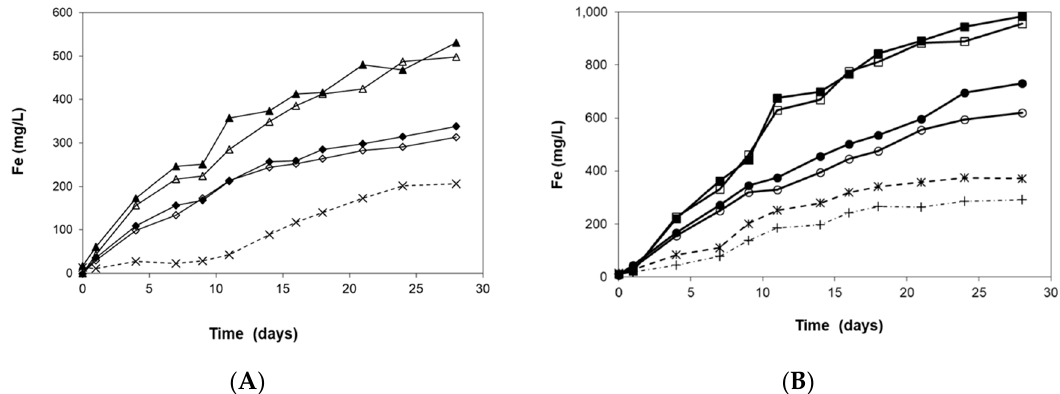
Figure 1. Total soluble iron (solid symbols) and ferrous iron (hollow symbols) leached from the laterite ore ( A ) under anoxic conditions using A. ferrooxidans at pH 1.8 and 30 °C, sparged with (i) oxygen-free nitrogen (OFN) ( ♦ , ◊ ) and (ii) OFN enriched with 10% of CO 2 ( ▲ , Δ ). ( B ) Under aerobic conditions using A. thiooxidans at (i) pH 0.9 ( ■ , □ ) and (ii) pH 1.2 ( ● , o). Dashed lines show the concentrations of total soluble iron in the non-inoculated reactors: anoxic, pH 1.8 (x); aerobic, pH 1.2 (+); aerobic, pH 0.9 ( ).